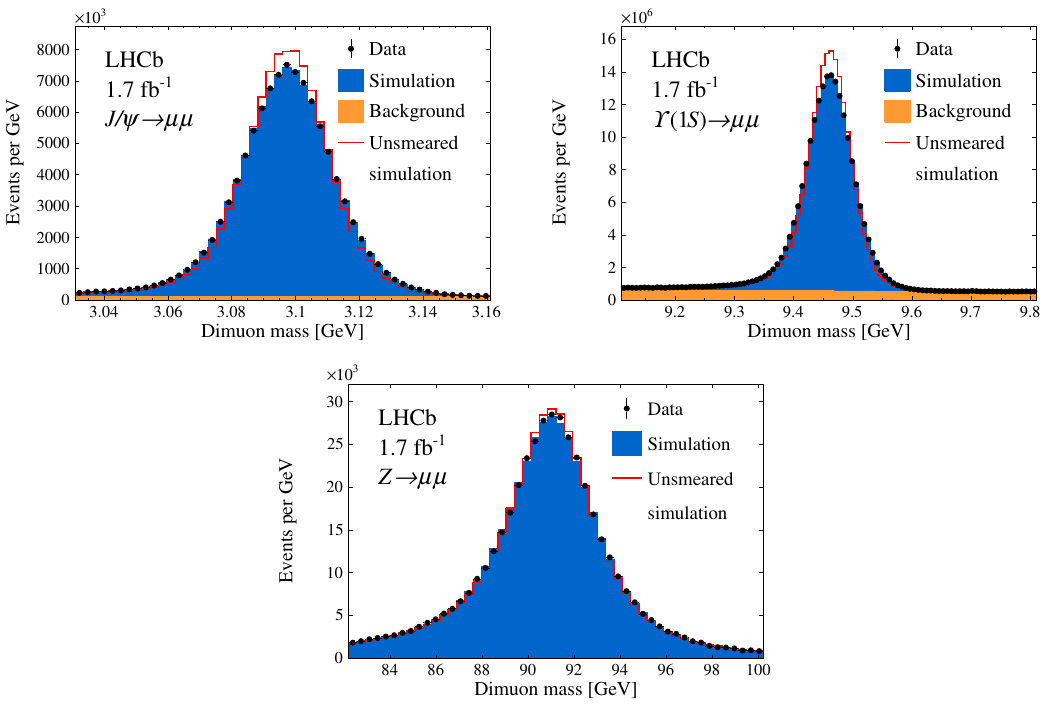
Figure 3 . Dimuon mass distributions for selected J/ψ , Υ (1 S ) and Z boson candidates. All categories with both muons in the 2 . 2 < η < 4 . 4 region are combined. The data are compared with the fit model. The red histogram delineates the model before the application of the smearing.